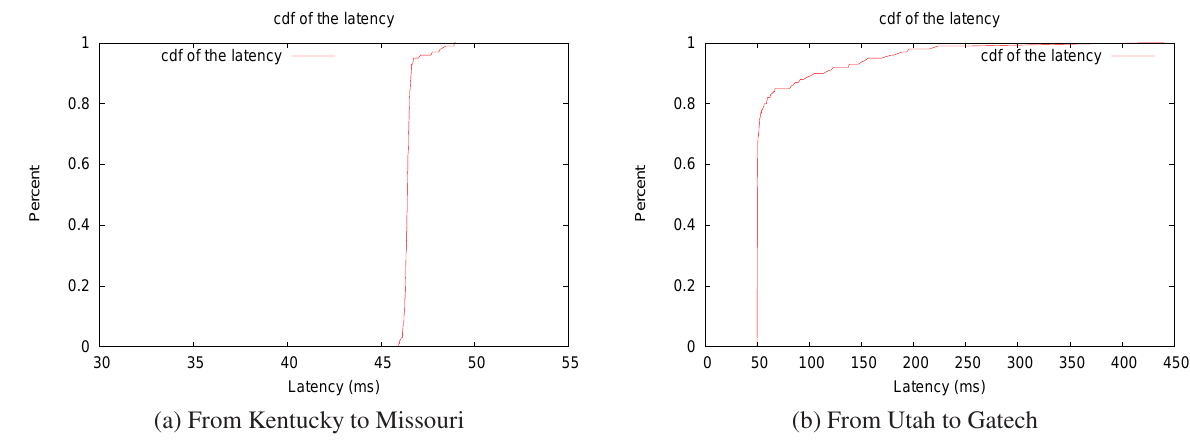
Figure 6. cdf of latency of links cross